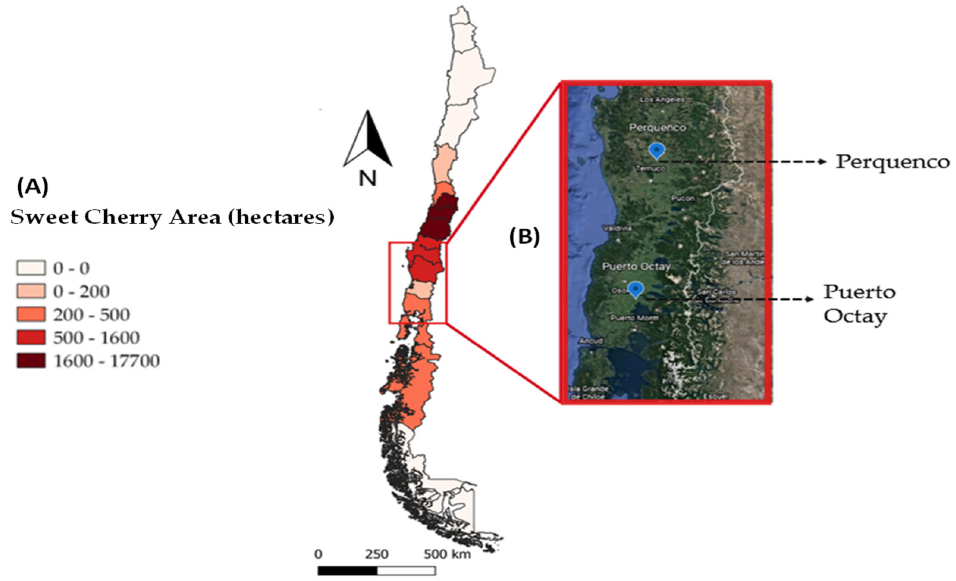
Figure 4. Distribution of the sweet cherry planting area in Chile (Source: ODEPA, 2021) ( A ) and location of the study orchards at southern Chile ( B ).